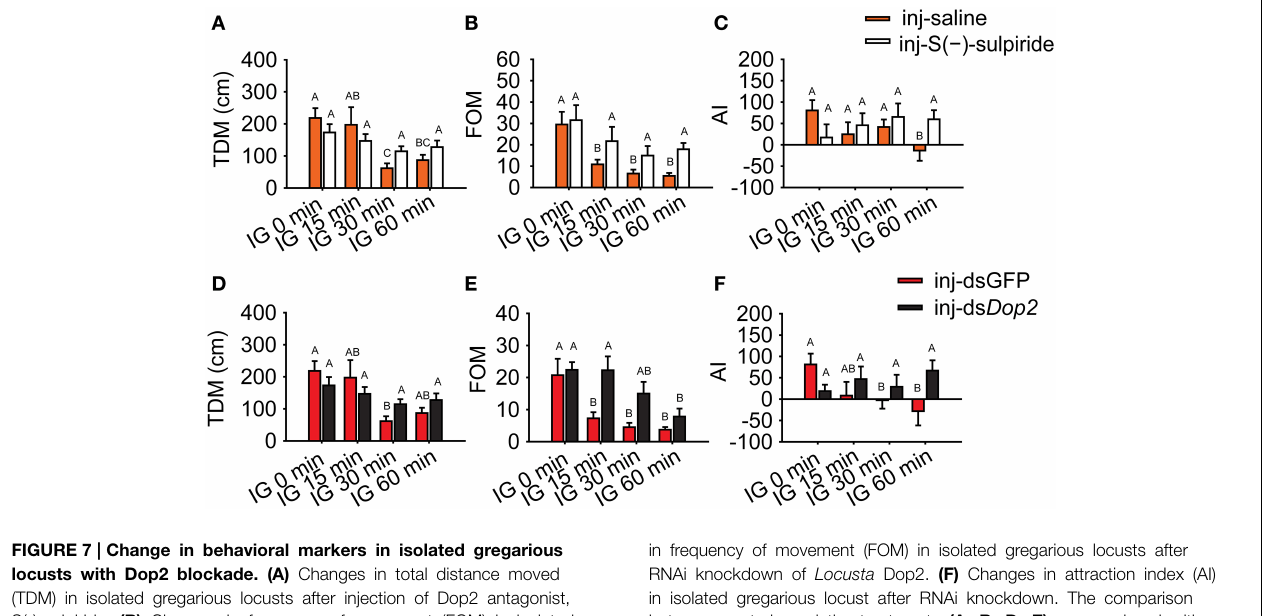
in frequency of movement (FOM) in isolated gregarious locusts after RNAi knockdown of Locusta Dop2. (F) Changes in attraction index (AI) in isolated gregarious locust after RNAi knockdown. The comparison between controls and the treatments (A, B, D, E) was analyzed with One-Way ANOVA followed by post-hoc Tukey test for multiple comparisons. The behavioral comparison between controls and treatments (C, F) was analyzed by Mann–Whitney U -test. Abbreviations: IG, isolation of gregarious locusts.